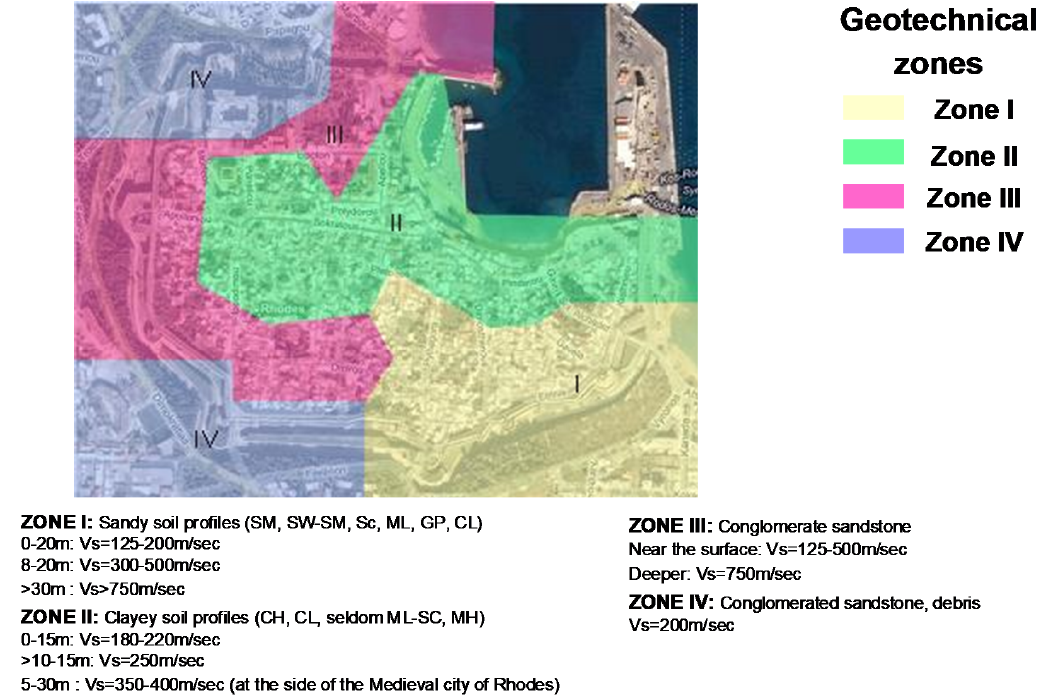
Figure 5. Geotechnical map of Rhodes [48].